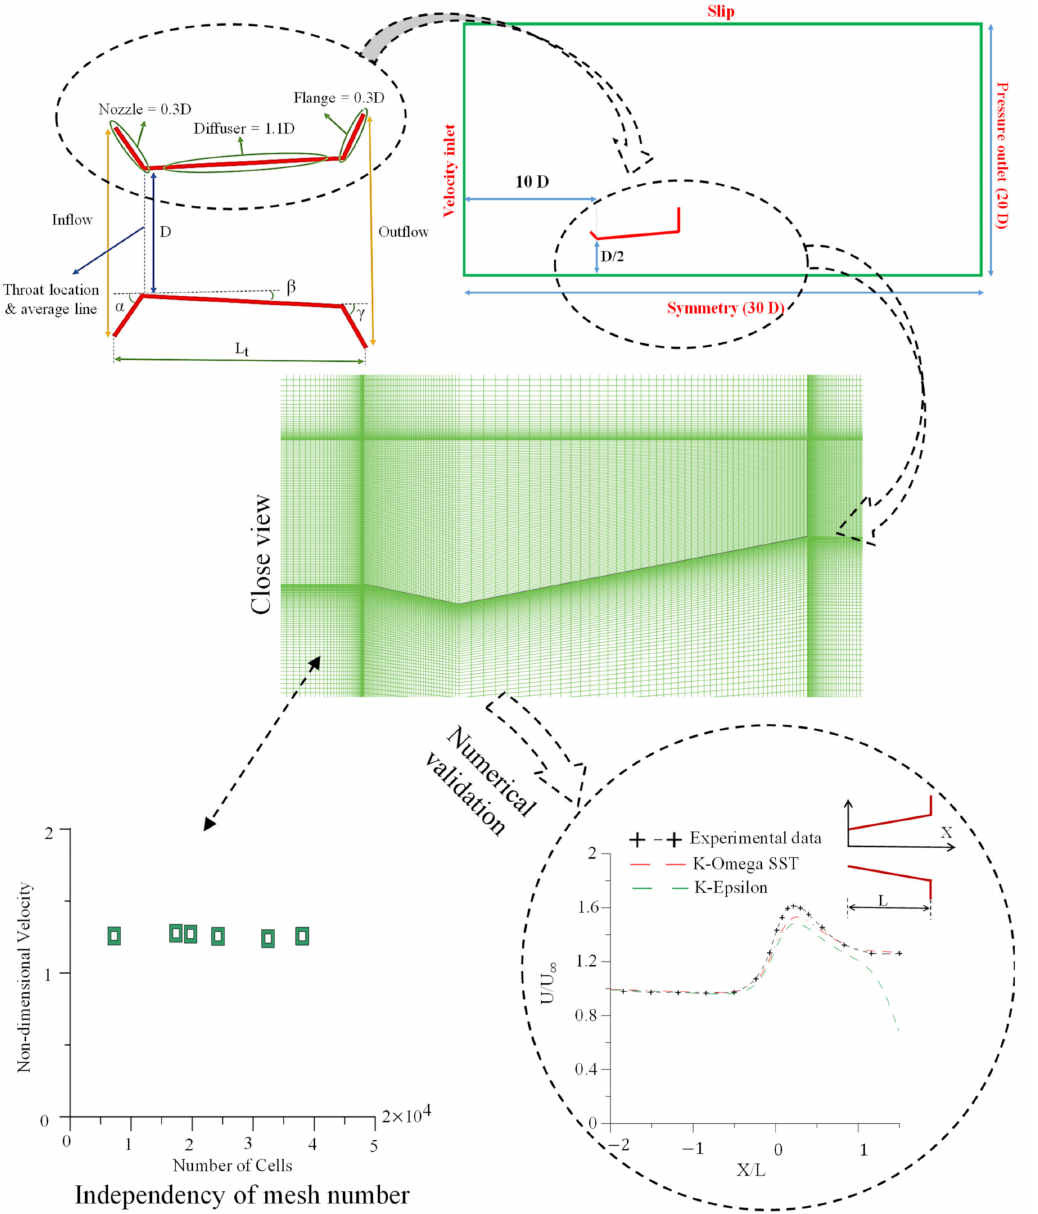
Figure 1. Numerical approach for duct study and validation by experimental results of Ohya and Karasudani